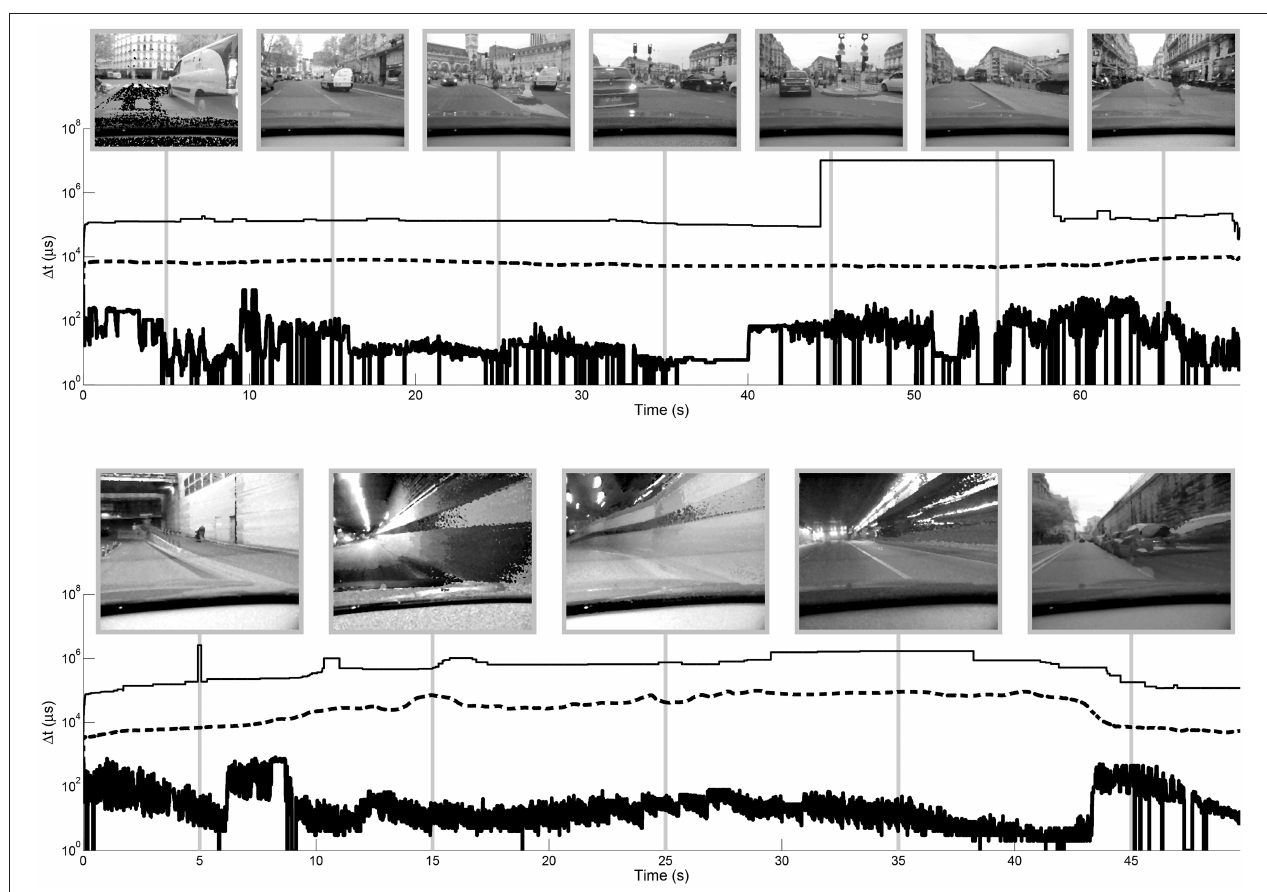
FIGURE 8 | Evolution of dynamic range of the “city” (top) and “tunnel” (bottom) videos over time. Maximum, median and minimum time differences are plotted in over time on a semilog axis. Snapshots are shown with logarithmic tone mapping. A spatial median filter is applied to the input data prior to recording the maximum, median and minimum values to remove noise due to unresponsive or over-sensitive pixels (single black and white pixels in examples). The strong discontinuity in the maximum time difference for the “city” video between approx. 45 and 52 s is due to noise that is still present after median filtering on pixels that are infrequently updated. These values are not necessarily distinguishable in the videos since they represent few pixels that may be saturated (in the case of the linear and logarithmic tone mapping) on an equally dark